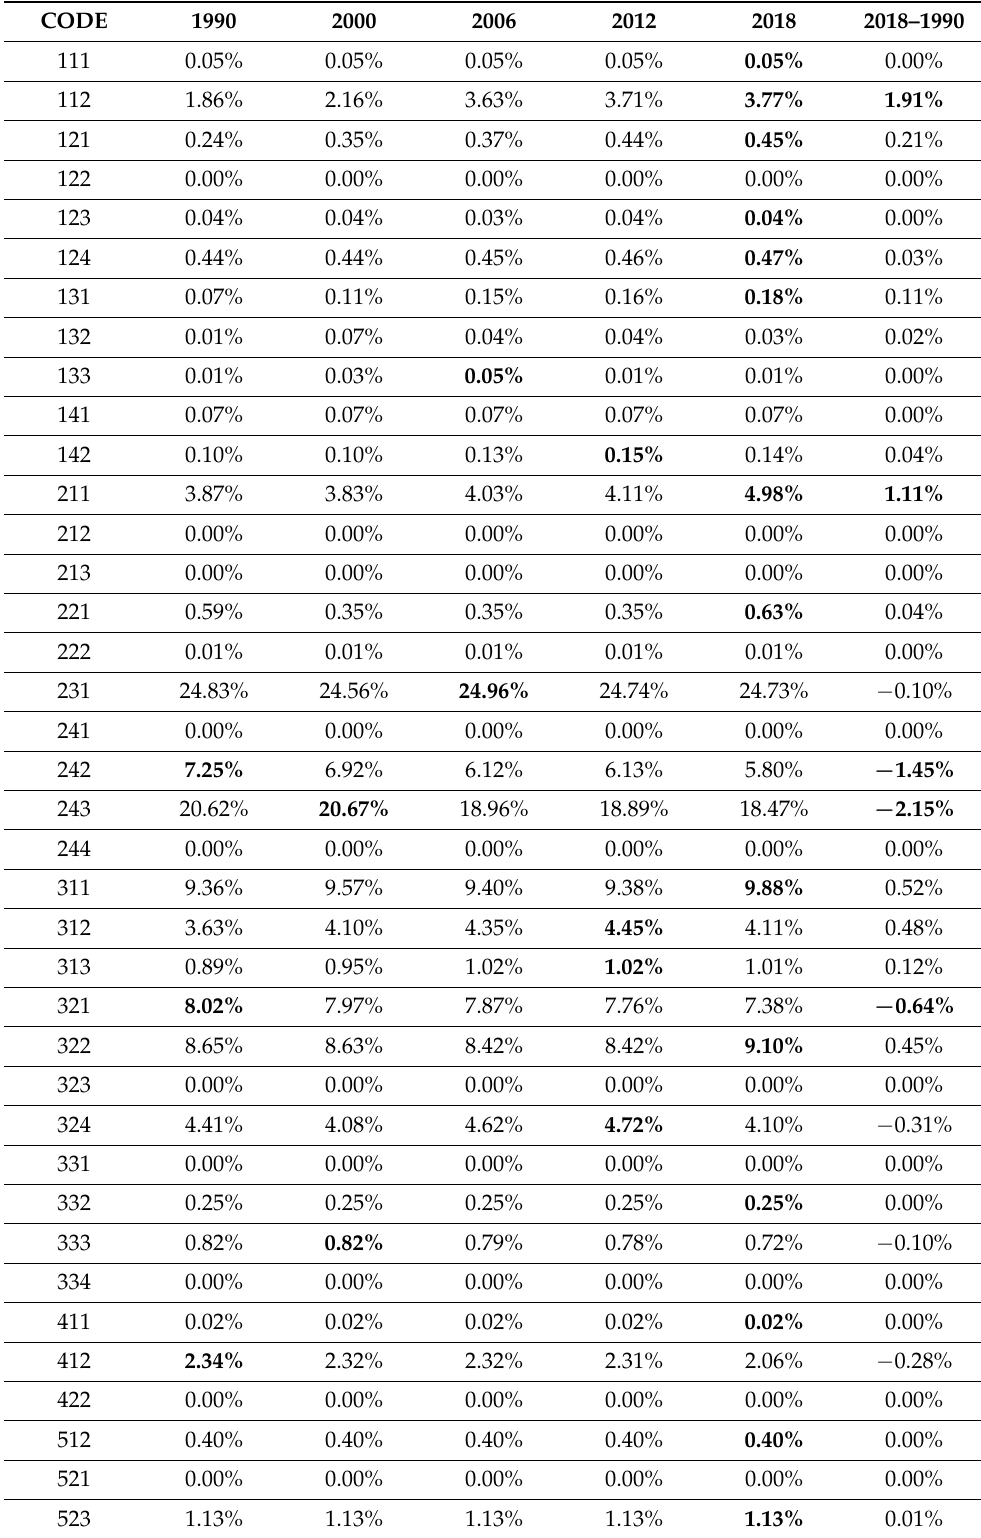
Table 3. Percentage of land-uses according to level 3 of CLC nomenclature in the Autonomous Region of the